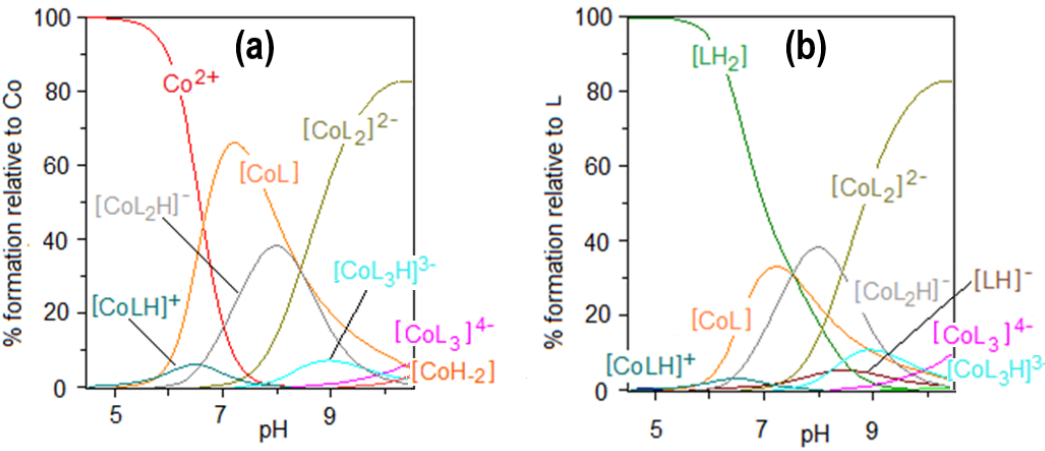
Figure 3. Species distribution curves for the complexes formed in the Co(II)–AlaSal system at ligand-to-metal molar ratio 2:1 as a function of pH relative to ( a ) Co(II), ( b ) ligand; C AlaSal = 2.0 × 10 − 2 M.